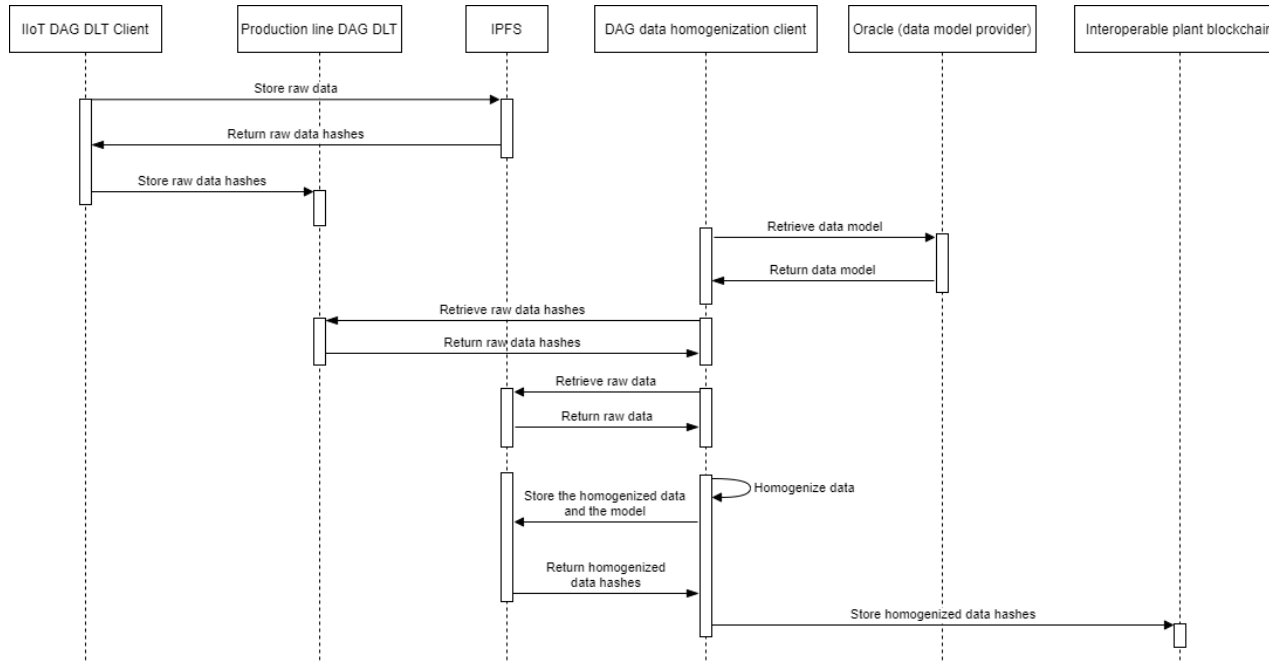
Figure 4. Sequence diagram of the proposed oracle-based